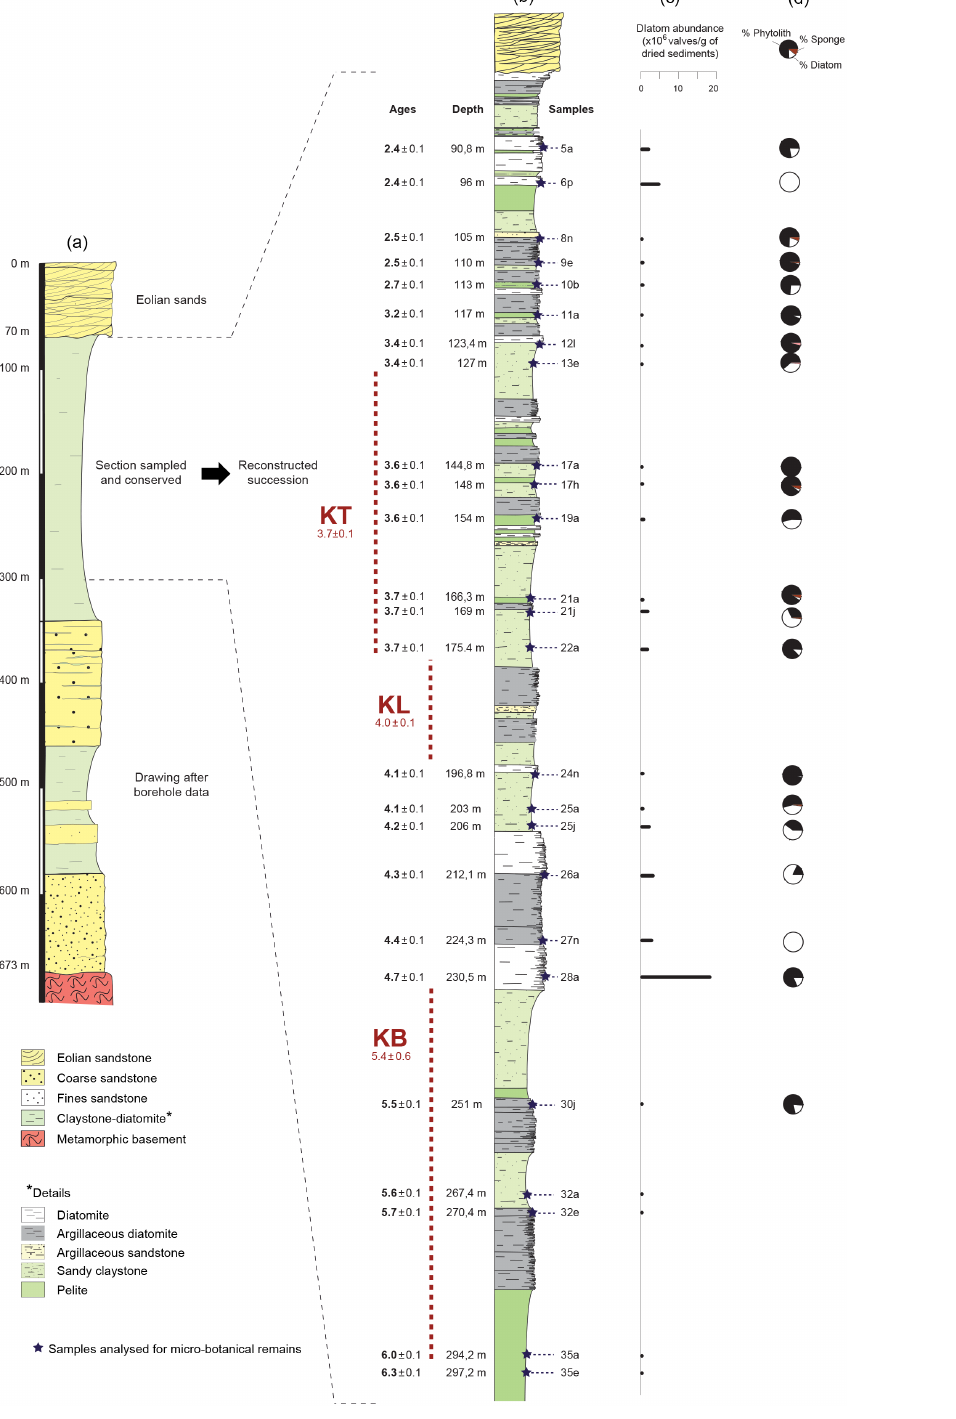
Figure 3. Sedimentology of the Bol borehole, chronology and stratigraphical positions of the 25 samples studied in detail (from Novello et al., 2015) with (a) general lithological succession of the whole core and 10 Be chronology (the position of the Mio-Pliocene fossil sites from Djourab is located in parallel to the chronology of the borehole), (b) a detailed sequence reconstructed from preserved cuttings, (c) diatom concentration in the studied samples (number of valves/g dry sediments), and (d) quantification of phytoliths, diatoms and sponge spicules recovered in the silicified assemblages (Novello et al., 2015; Moussa et al.,